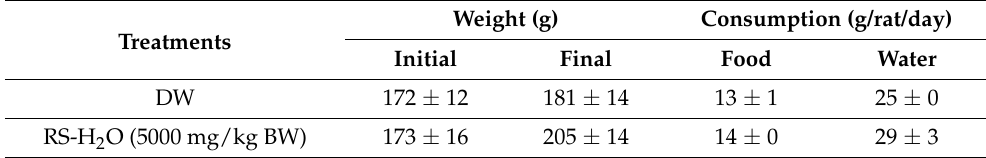
Table 3. Effects of high single dose RS on rat body weight (BW) and food/water consumption.